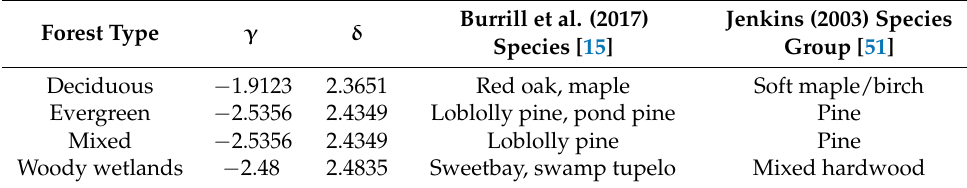
Table 6. Parameters of AGFB (B)—tree diameters (DBH) functions (2).